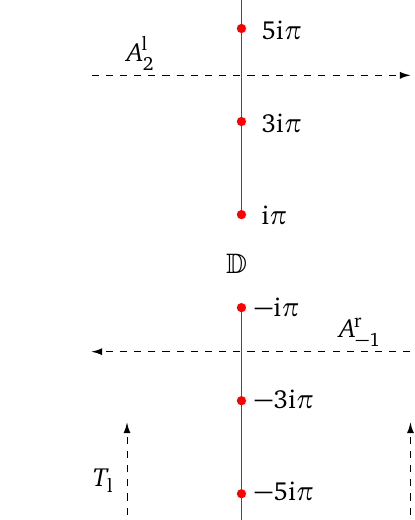
Figure 18: Two possible choices of branch cuts for the function χ (cid:59) . The choice on the left, corresponding to the principal value of the polylogarithm Li not convenient because of the presence of symmetries v (cid:55)→ v + 2i π . The choice on the right, which is the one actually used in the paper, defines by removing the cuts a space (cid:68) = (cid:67) \ (( − i ∞ , − i π ] ∪ [ i π ,i ∞ )) on which the chosen determination of χ (cid:59) is analytic. Examples of paths of analytic continuation for the translation operators T T and the analytic continuation operators A l r also indicated on the right with dashed